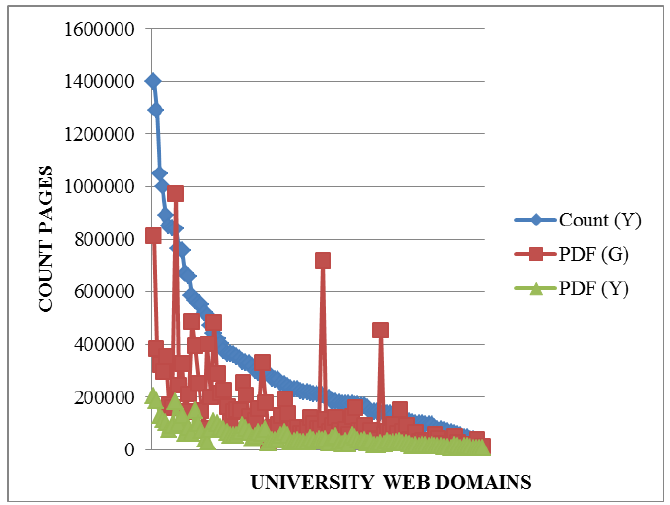
Figure 1. Distribution of page count indicators for URLs.